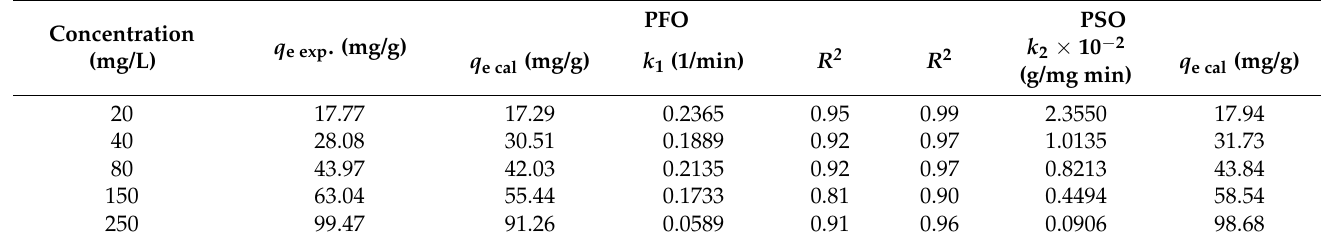
Table 7. PFO and PSO kinetic parameters for MV 2B adsorption onto MCAC.